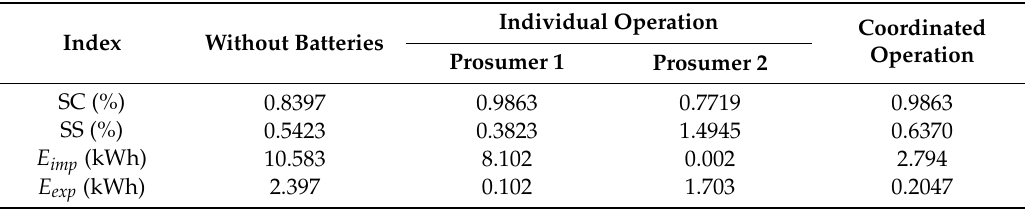
Table 1. Self-consumption (SC) and self-sufficiency (SS) indices and imported and exported energy as a result of batteries management.